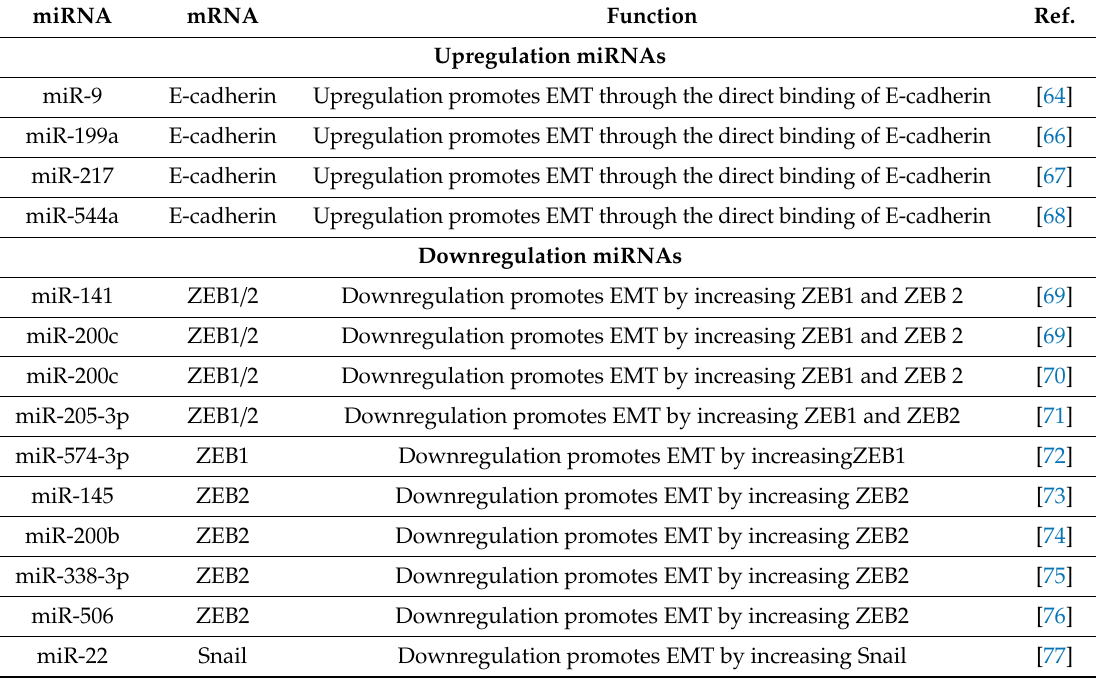
Table 1. Summary of all miRNAs and mRNA interaction and their roles in the EMT process associated with di ff use-type gastric